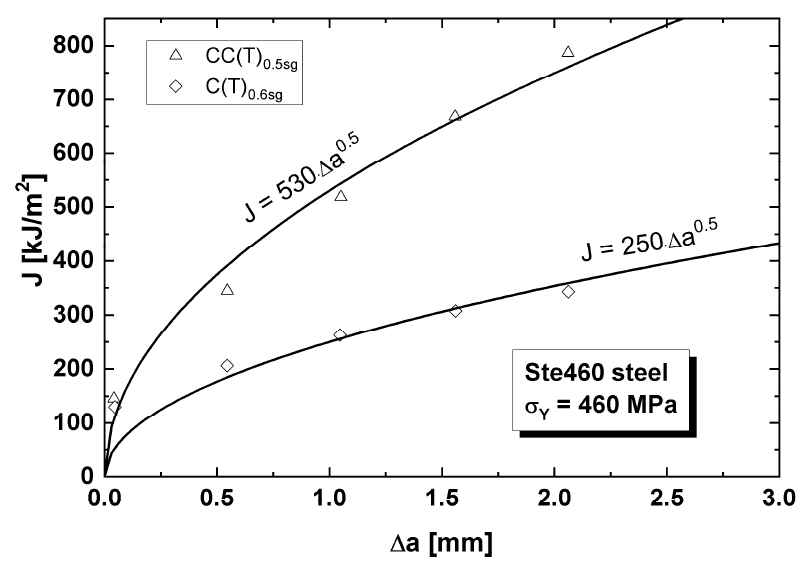
Figure 6. Comparison of CC(T) and C(T) specimen tearing resistance (J-integral versus crack exten- sion ∆ a) for a medium-strength steel [7].